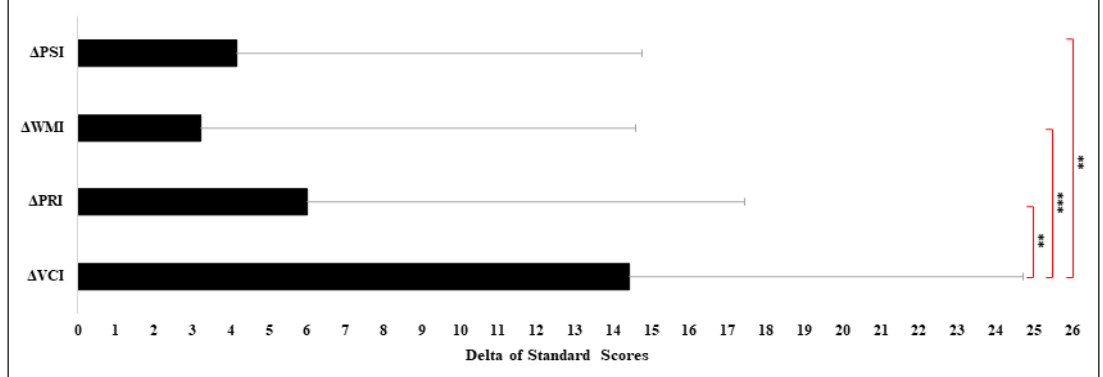
Figure 2. Δ Indexes of Wechsler Scale in our cohort of KBGS (KBG syndrome). Legend: Δ VCI : delta verbal comprehension Figure 2. ∆ Indexes of Wechsler Scale in our cohort of KBGS (KBG syndrome). Legend: ∆ VCI : delta verbal comprehension index (VCI − Full-IQ); Δ PRI: delta perceptual reasoning index (PRI − Full-IQ); Δ WMI : delta working memory index (WMI − index (VCI − Full-IQ); ∆ PRI: delta perceptual reasoning index (PRI − Full-IQ); ∆ WMI : delta working memory index Full-IQ); Δ PSI: processing speed index (PSI − Full-IQ). ** p ≤ 0.01; *** p ≤ 0.001. (WMI − Full-IQ); ∆ PSI: processing speed index (PSI − Full-IQ). ** p ≤ 0.01; *** p ≤ 0.001. Table 4. Adaptive behaviour of children and adolescents with KBG syndrome.